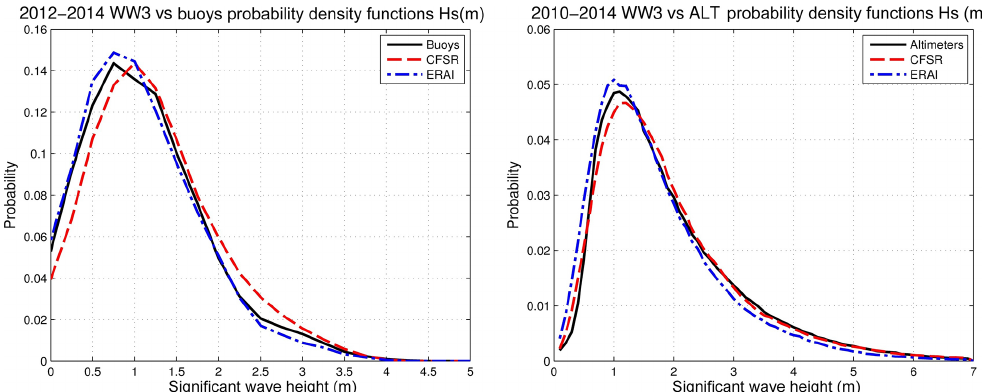
Figure A4. H s probability distributions for CFSR and ERAI versus the buoys (left) and altimeters (right).